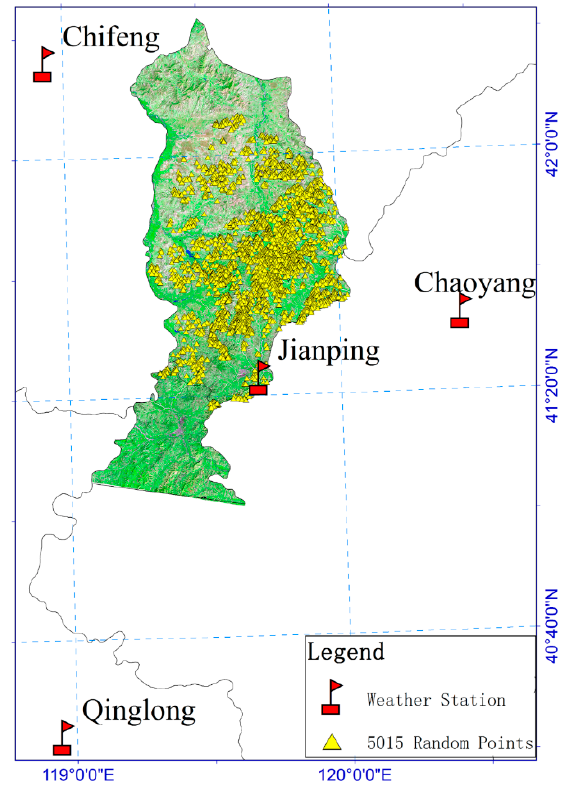
Figure 3. Locations of four meteorological stations and 5015 plots of public random points.